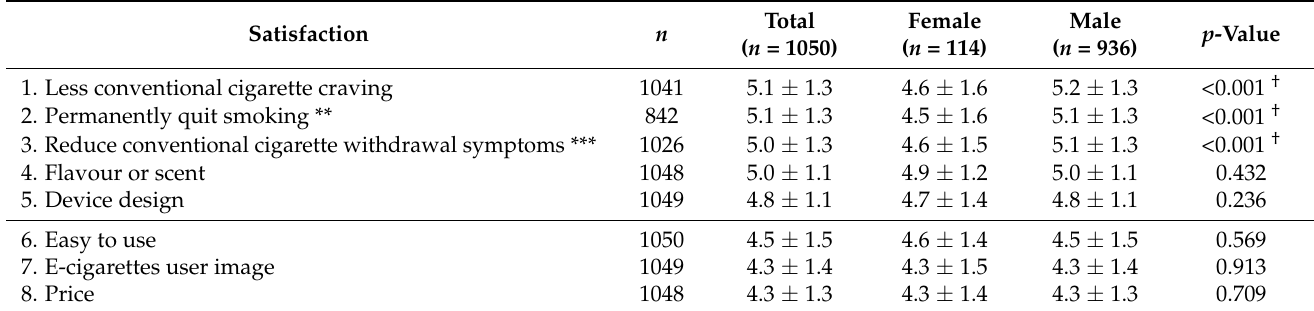
Table 4. Satisfaction of e-cigarettes users by sex